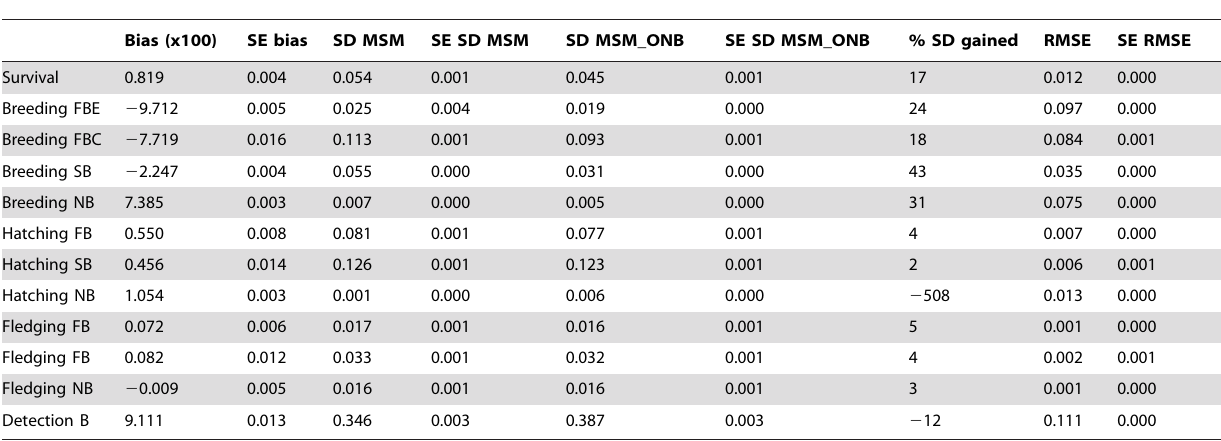
Table 1. Summary of averaged performance of estimators across ages [Bias, Standard Deviation (SD), Root Mean Square Error (RMSE) and their respective Standard Errors (SE)], for each demographic trait and corresponding previous state: F=